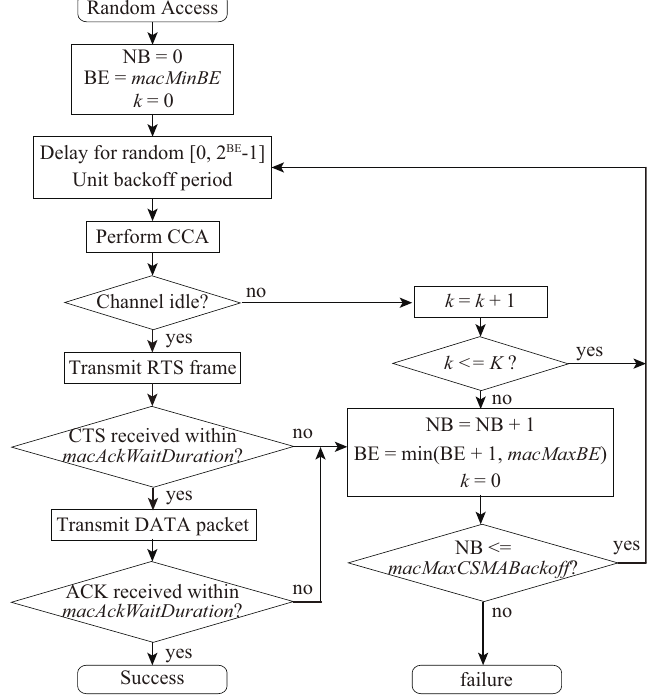
Figure 5. Random–access procedure for the proposed backoff